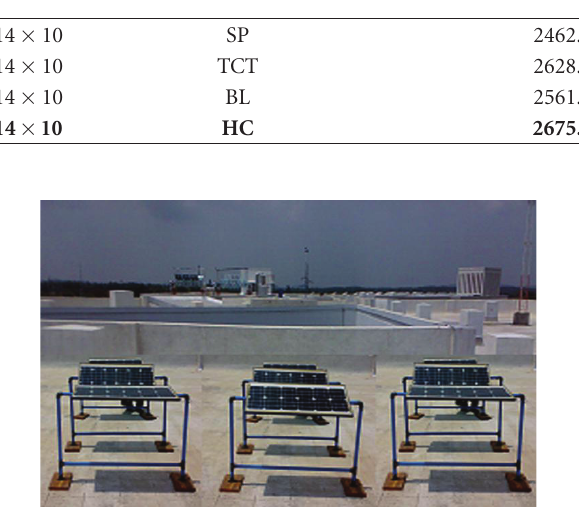
Figure 10: Practical setup of a 3 × 3 array employing tilting modules for di ff erent